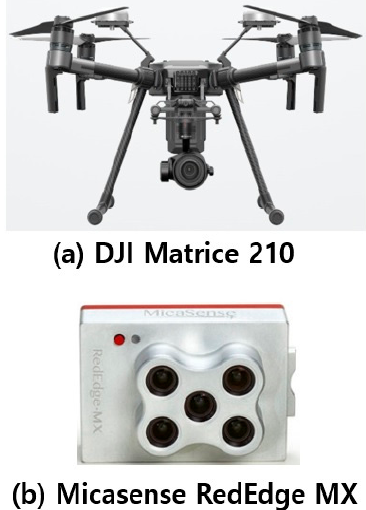
Figure 3. The Unmanned Aerial Vehicle (UAV) system: ( a ) DJI Matrice 210, ( b ) Micasense RedEdge MX.